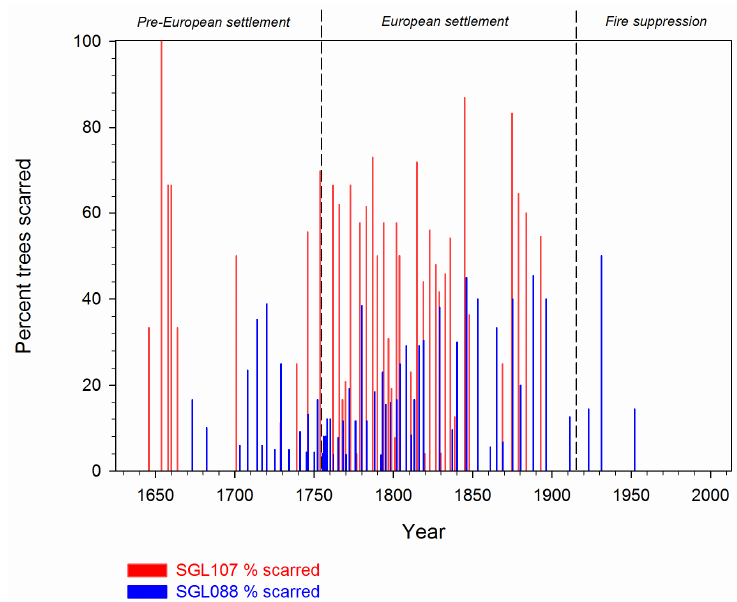
Figure 4. Percentage of trees scarred during fire years with at least 3 trees present in the tree-ring record at the two fire history study sites. Time periods separated by vertical dotted lines.